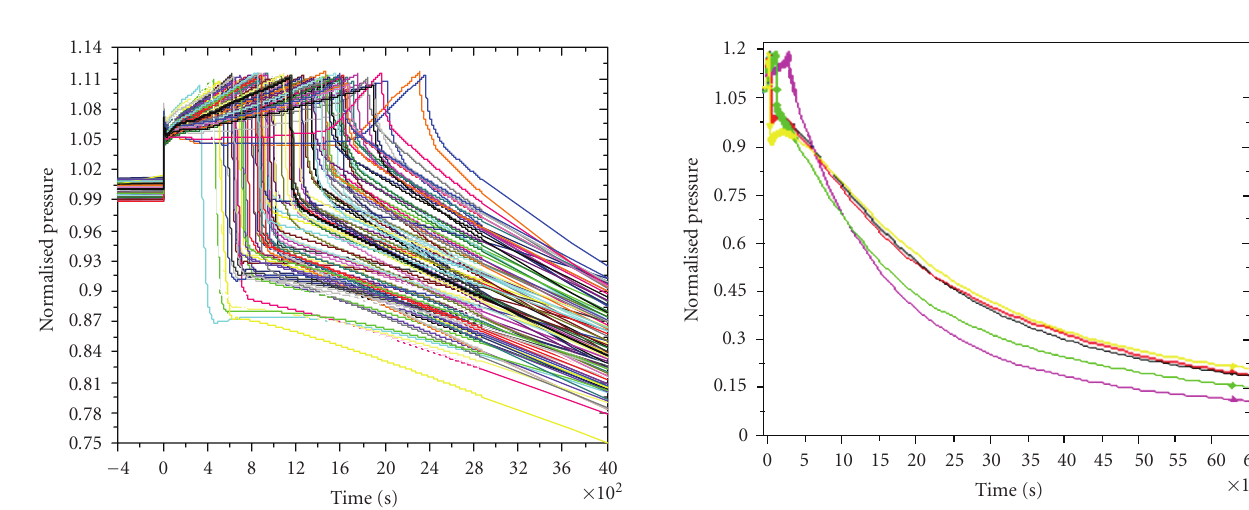
Figure 5: Cobweb plots of normalized parameters range.